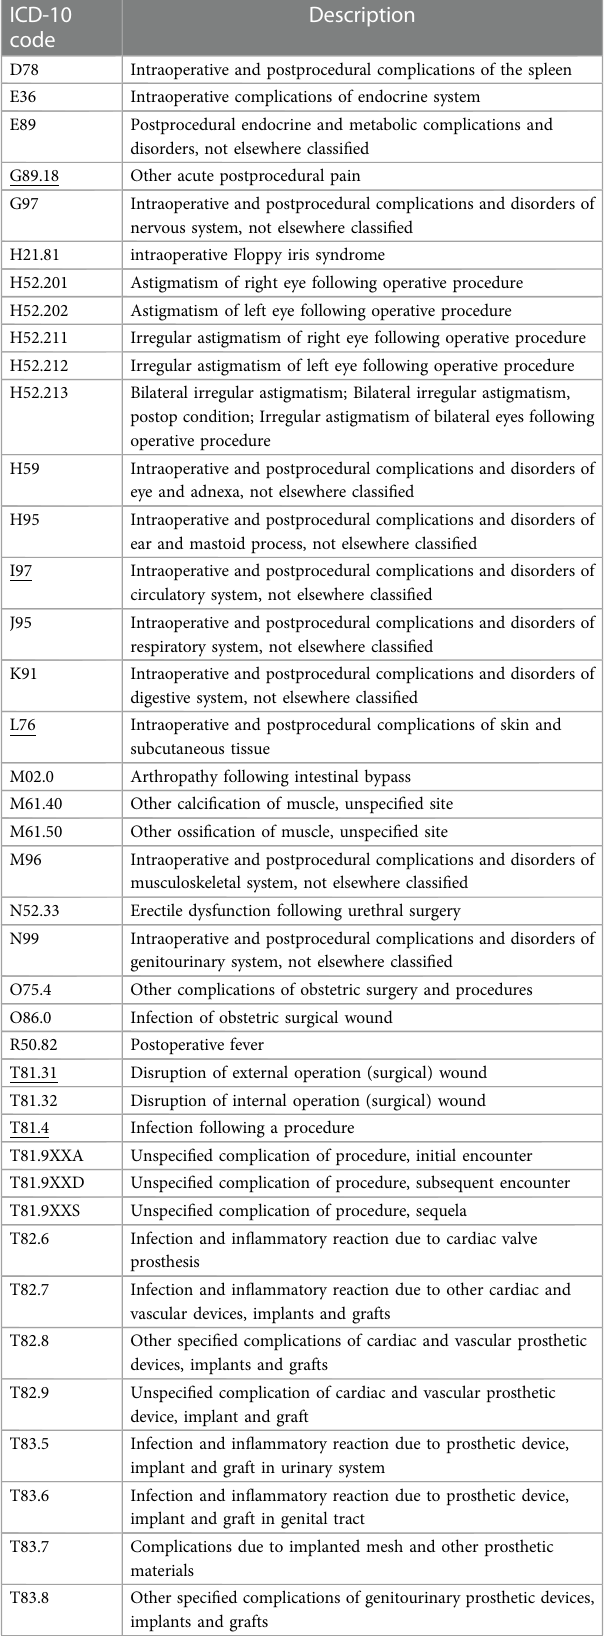
TABLE 2 Matched analyses of morbidity and mortality data . (A) PD compared to